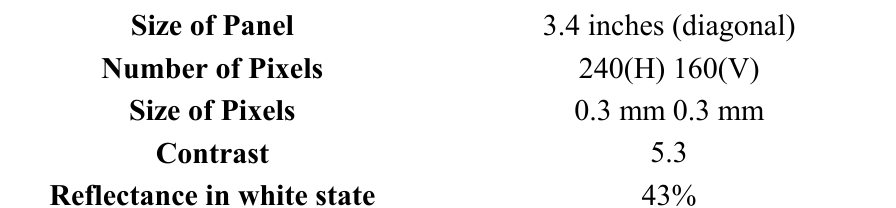
Table 10. The performances of the prototype of the reflective three-layer GH-LCD